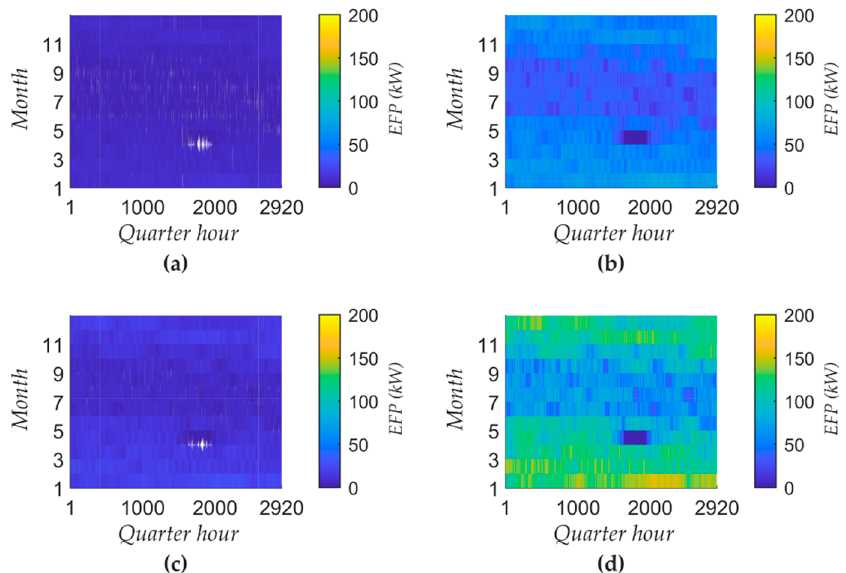
Figure 10. Technical energy-flexibility potential through adjusting process parameters: ( a ) Primary balancing power of the evaporator; ( b ) Primary balancing power of the superheater; ( c ) Energy- flexibility potential for day-ahead marketing of the evaporator; ( d ) Energy-flexibility potential for day-ahead marketing of the superheater.